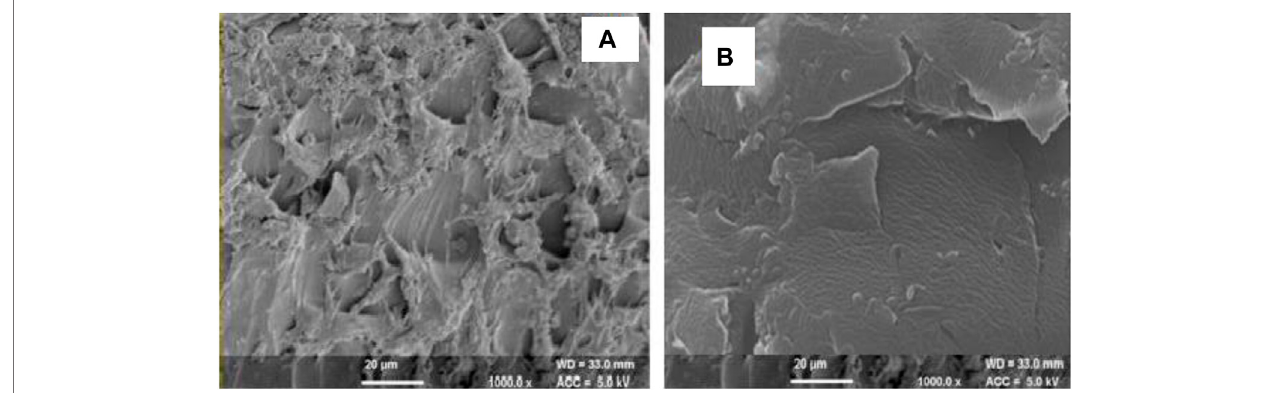
FIGURE 2 | (A,B) FESEM of (A) Kg-cl-poly (AA) and (B) Kg-cl-poly